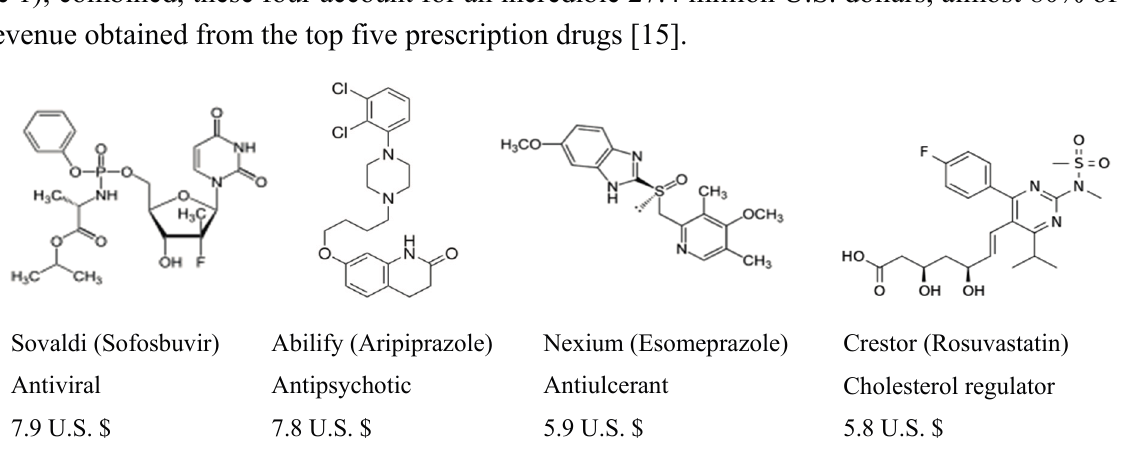
Figure 1. Heterocycle molecule drugs present in the US top five prescription drugs and respective retail sales in 2014 (in billions of U.S. $)